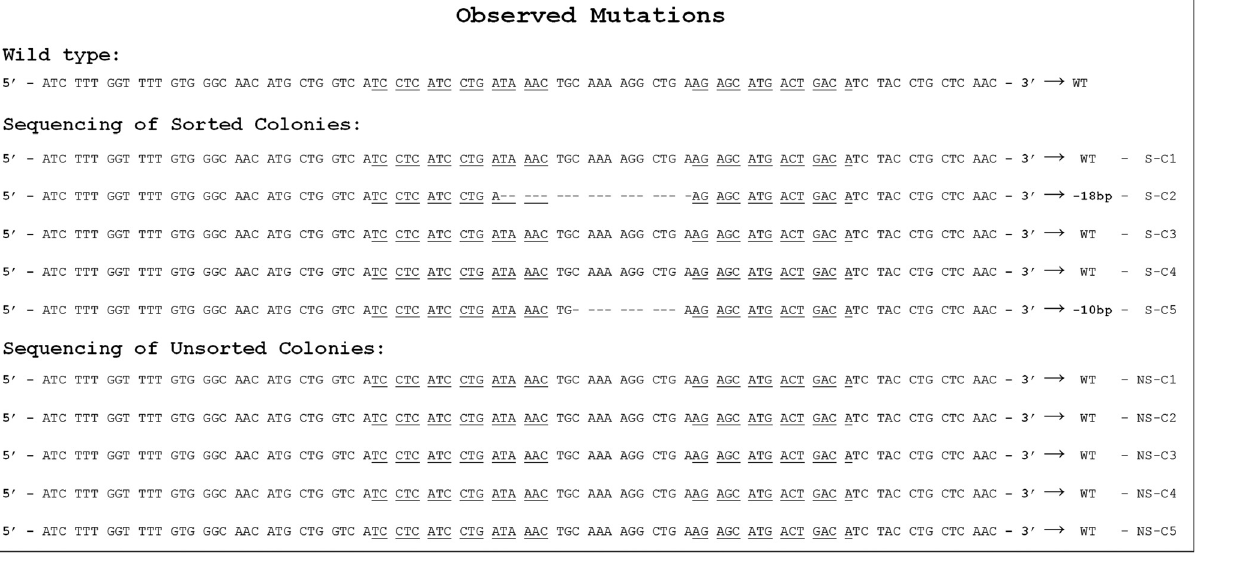
Figure 6 - Patterns of TALEN-mediated mutagenesis observed through sequencing of the Heteroduplex positive and negative colonies in the HMA. Se- quence alignment for the first exon of human CCR5. The wild-type sequence is shown at the top and the underlined sequence represents the recognition site for TALEN subunits (right and left) from “Strategy 2” (Miller et al. , 2011). Five clone sequences (S-C1 to 5) represent the sorted cells, with NS-C1 to 5 indicating the corresponding unsorted counterparts. The numbering of these sorted and unsorted colonies is the same as that of Figure 4. The size of the deletions is given in bp, and WT indicates clones with a sequence identical to that of the